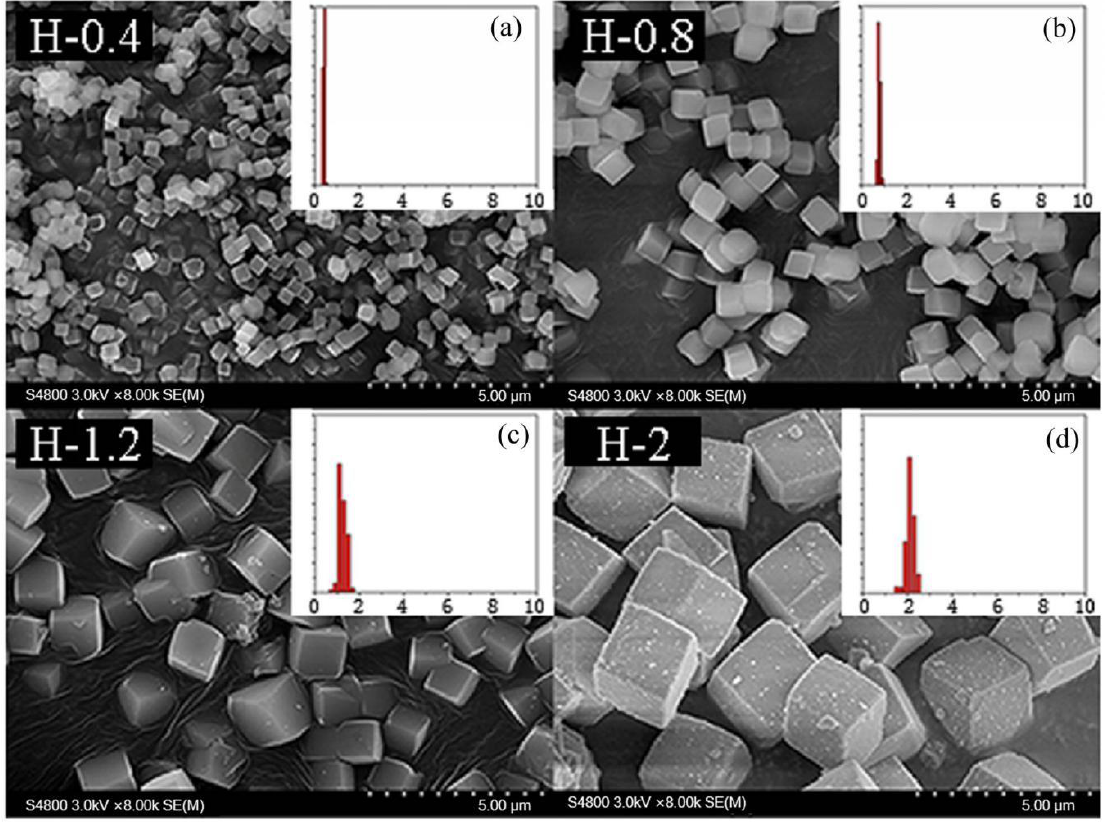
Figure 8. The SEM results of SSZ-13 with di ff erent sizes (Si / Al = 25). ( a ) H-0.4; ( b ) H-0.8; ( c ) H-1.2; ( d ) H-2. Synthesized gel compositions: 1 SiO 2 : 0.02 Al 2 O 3 : 0.025 Na 2 O: 0.1 SDA: 20 H 2